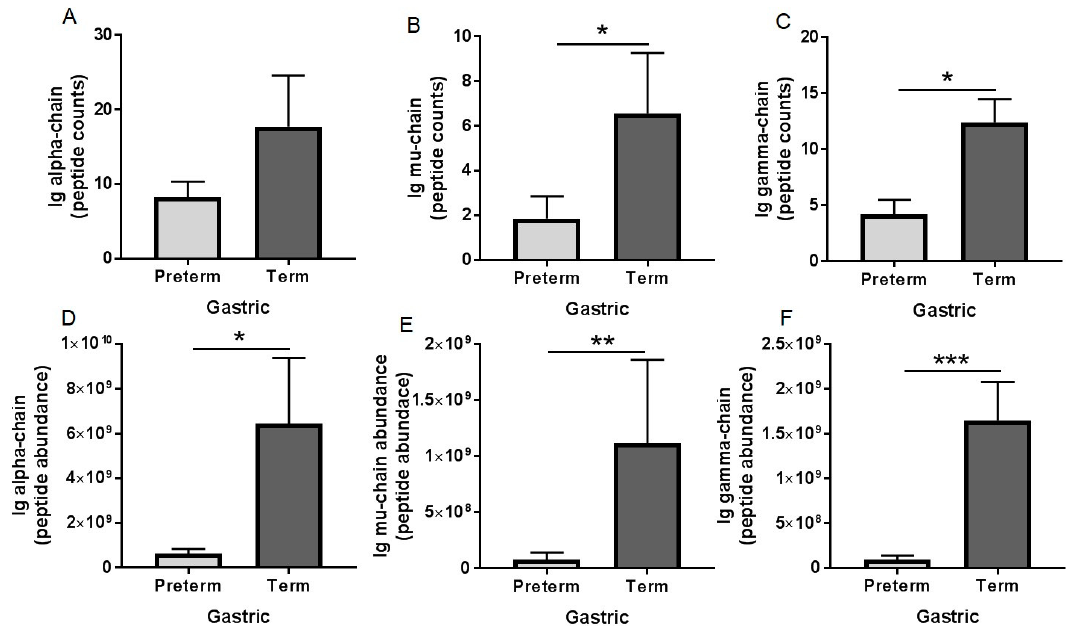
Figure 3. Peptide counts and abundance of human immunoglobulin fragments in human milk and gastric samples at 2 h postprandial time from paired mother-infant delivered prematurely (23–32 week of gestational age (GA), 7–98 days of postnatal age) and at term (38–40 week of GA, 16–42 days of postnatal age). ( A , D ) Ig alpha-chain (from SIgA/IgA) and ( B , E ) Ig mu-chain (from SIgM/IgM); ( C , F ) Ig gamma-chain (from IgG). Values are mean ± SEM, n = 15 for preterm infants and n = 8 for term infants. Asterisks show statistical significant differences between variables (*** p < 0.001; ** p < 0.01; * p < 0.05) using the Mann–Whitney test (unpaired samples).